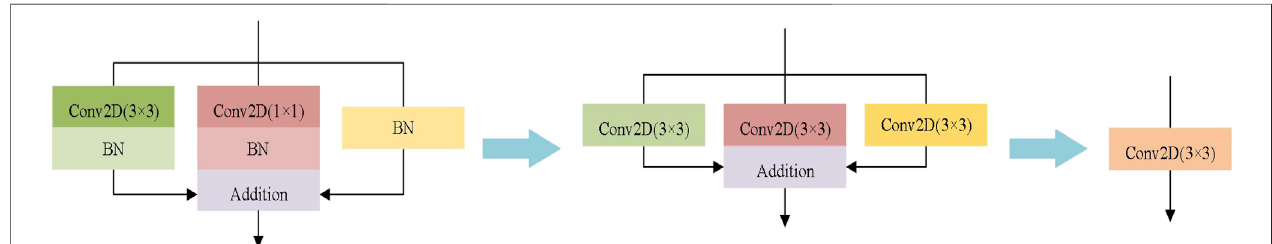
FIGURE 4 | The procedure of